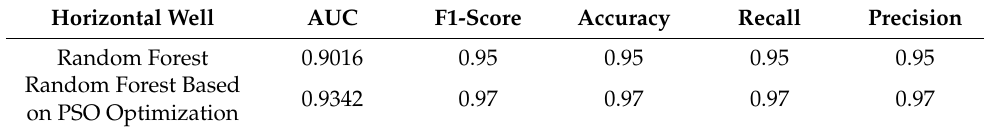
Table 4. Comparison of accuracy before and after algorithm improvement under horizontal well